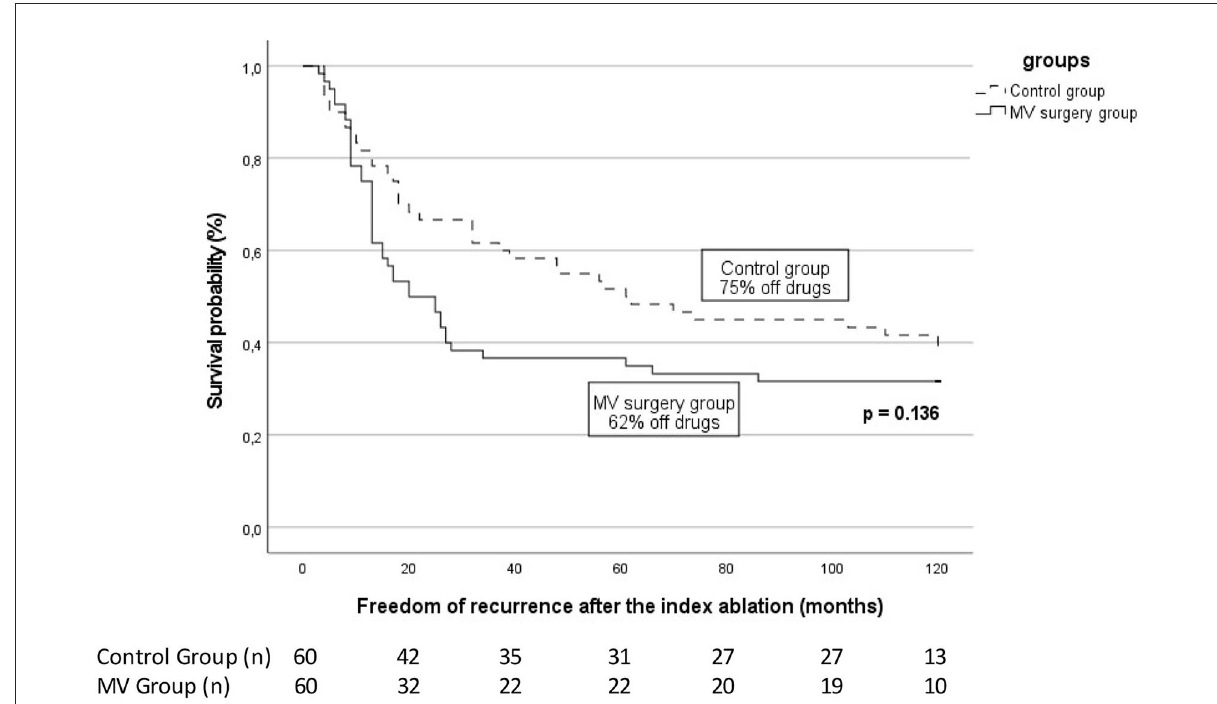
FIGURE1 Arrhythmia-free survival after the index catheter ablation for atrial fibrillation in patients with previous mitral valve (MV) surgery patients vs. control. The proportion of patients off antiarrhythmic drugs is specified for each group. The number of patients at risk at each time interval is shown below the figure. The p -value reflects the log-rank significance at the end of the